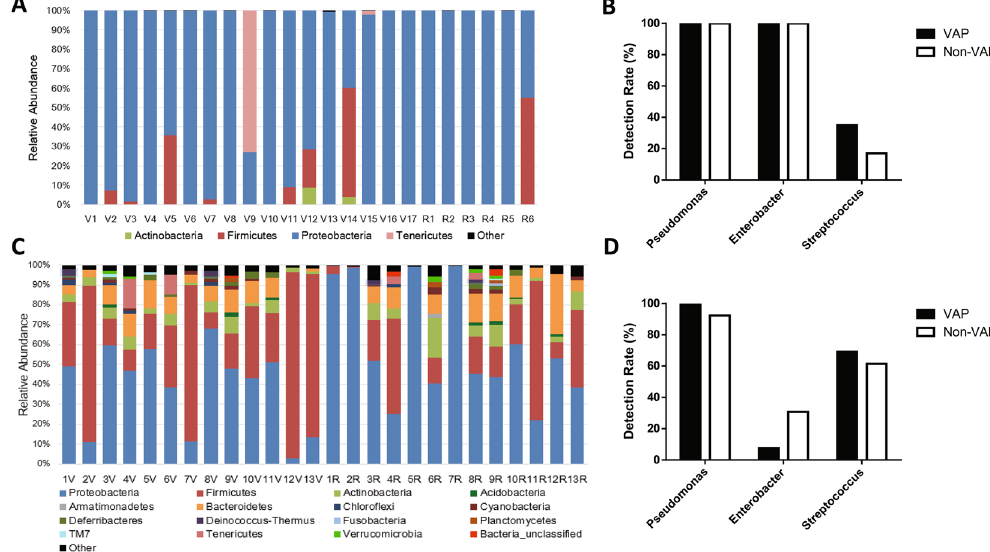
Figure 2. Bacterial communities in endotracheal tube biofilm. ( A ) Relative abundance of sequences belonging to different bacterial phyla in endotracheal tube biofilms of the 23 neonatal respiratory distress syndrome (NRDS) patients in the study. The y-axis indicates the relative abundance of phyla, and the x-axis indicates different samples from patients with concurrent ventilator-associated pneumonia (VAP) (V1–V17) and without VAP (R1–R6). ( B ) The detection rates of the three dominant genera in endotracheal tube biofilms of the 23 NRDS patients. ( C ) Relative abundance of sequences belonging to different bacterial phyla in endotracheal tube biofilms of the 26 patients with pneumonia in the study. The y-axis indicates the relative abundance of phyla, and the x-axis indicates different samples from patients with concurrent VAP (1V–13V) and without VAP (1R– 13R). ( D ) The detection rates of the three dominant genera in endotracheal tube biofilms of the 26 pneumonia